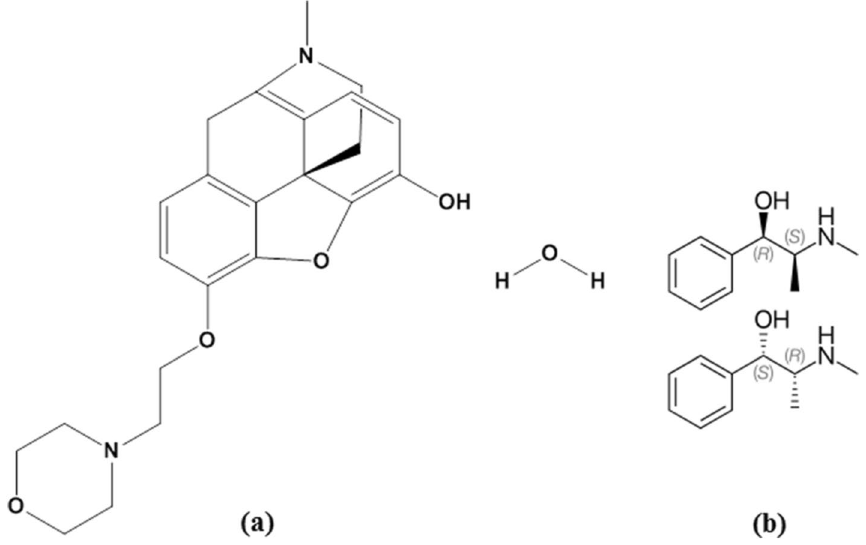
Figure 1. Chemical structure of the studied drugs: ( a ) PHL ( b )